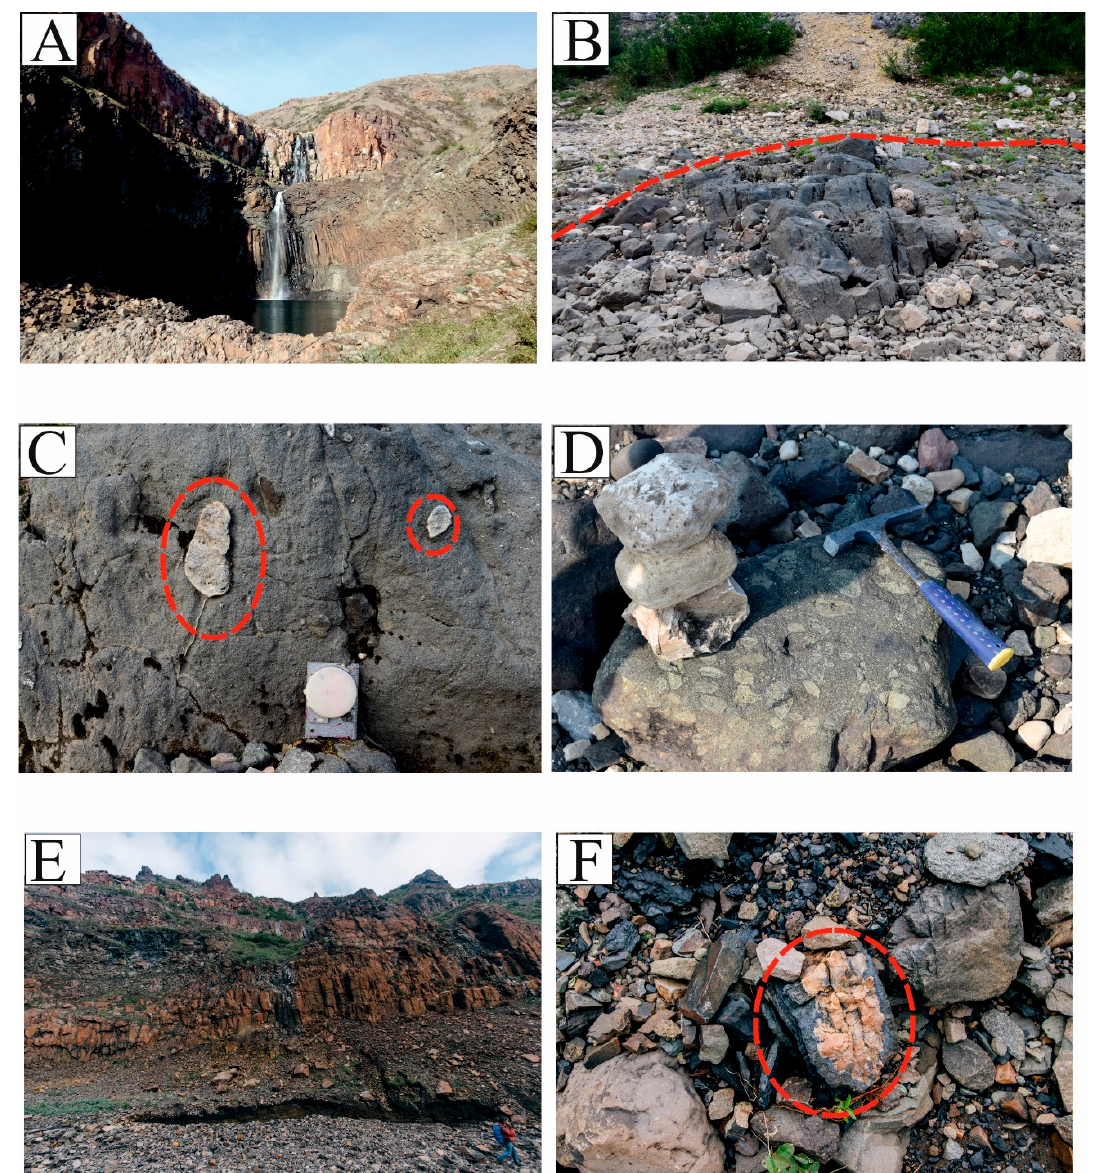
Figure 10. ( A ) Lava flows in the bottom of Ivakinsky Formation near the town of Talnakh. Thickness of the lowermost flow is about 50 m. ( B ) An outcrop of the alkaline-ultramafic breccia pipe in the Kotuy river valley. ( C ) Large clasts of syenites and ultramafic rocks in the volcanic breccia, the Kotuy river. ( D ) Boulder of olivine-rich breccia with lithic clasts of meimechites, the Kotuy river. ( E ) Sill of the Yergalakhsky complex intruding coal-bearing sediments of the Tunguska Group, the Norilsk region. ( F ) Intrusive contact of Yergalakhsky trachydolerites and coals of the Tunguska Group (in a boulder).